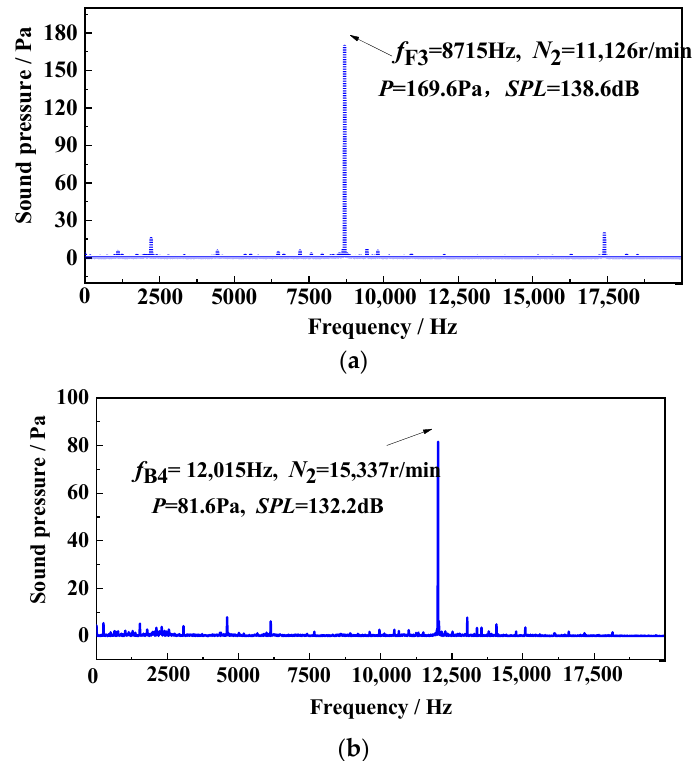
Figure 8. Noise spectrum of traveling wave resonance: ( a ) FTW of the 3rd ND; ( b ) BTW of the 4th ND.